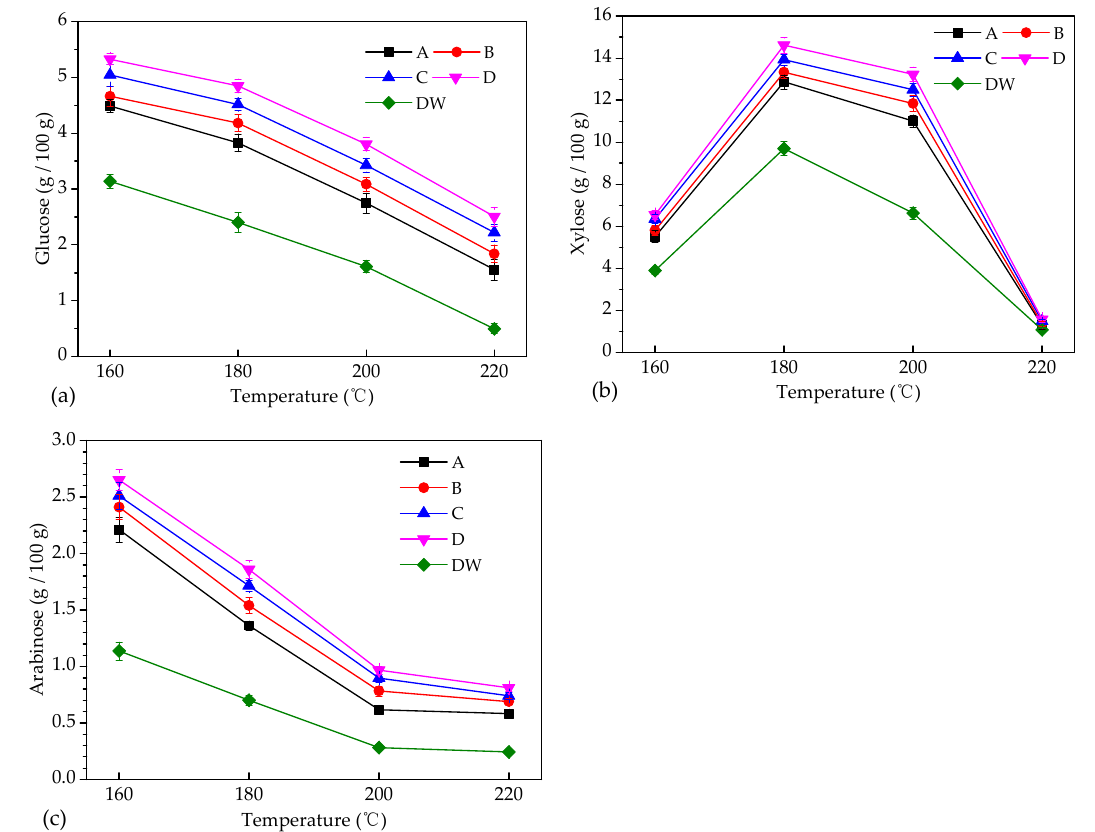
Figure 3. Comparison of pretreatment effects of an ultra-low concentration of FeCl 2 and distilled water on corn straw with the reaction temperature of 160 °C, 180 °C, 200 °C, 220 °C, and the time of 20 min. The amount of sugar produced in the reaction solution are as follows: ( a ) glucose; ( b ) xylose; ( c ) arabinose; Legend. DW( ◆ ), A( ■ ), B( ● ), C( ▲ ) and D( ▼ ) represent distilled water , 1 × 10 − 5 mol/L, 5 × 10 − 5 mol/L, 1 × 10 − 4 mol/L, and 5 × 10 − 4 mol/L, respectively.